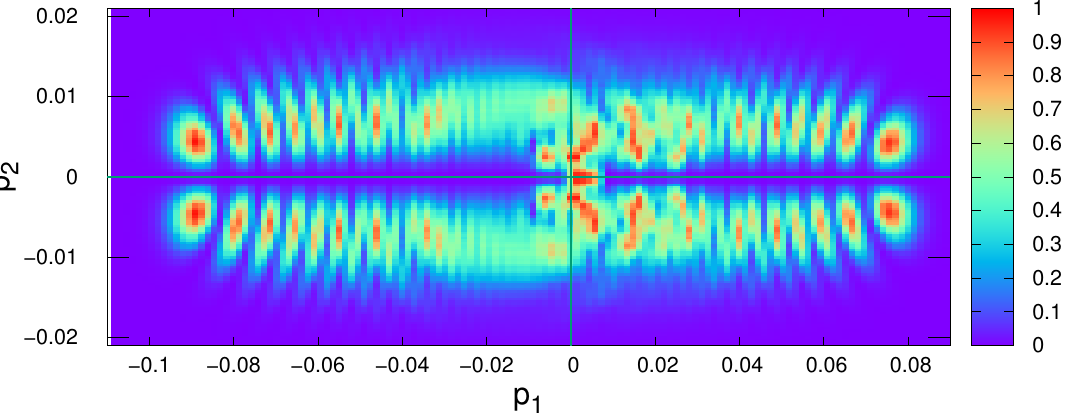
Figure 6. Distribution function f ( p 1 , p 2 ) formed under the action of the field (60) shown in Figure 5 at 6.0 10 − 13 s after passing the maximum of the field ×